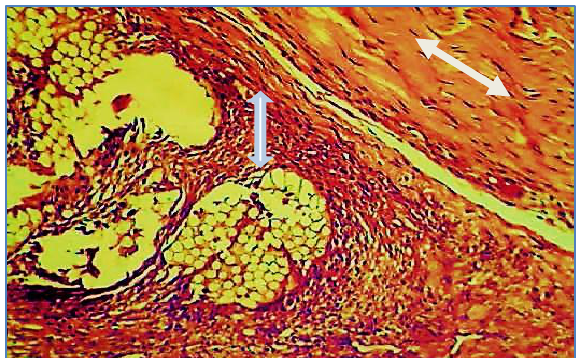
Figure, 8: In second group, 2 months post-implantation shows granulation tissue surrounding the narrow mesh holes (blue arrow) with tendon fibers expressed proliferation of tenocytes (empty arrow) (H&E stain;10X).